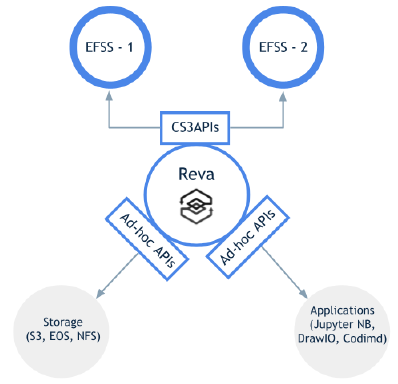
Figure 3. Reva: interoperability across